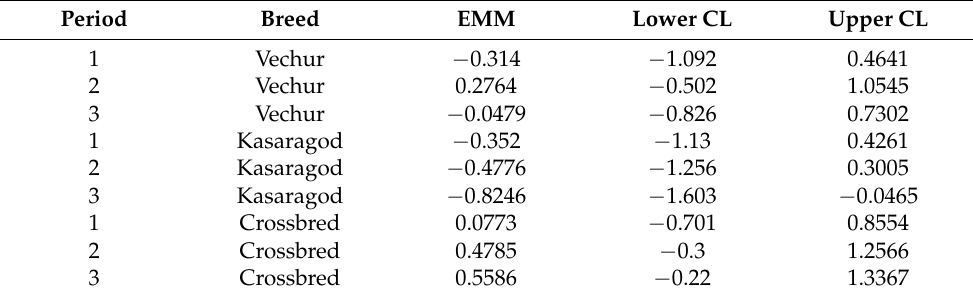
Table 2. Estimated marginal means (EMM) of the relative expression of ATP1A1 gene in different breeds of cattle at different periods from 08:00 to 12:00 (standard error = 0.37; df = 18). Period 1 was between 08:00 and 10:00; period 2 was between 10:00 and 12:00; period 3 was between 08:00 and